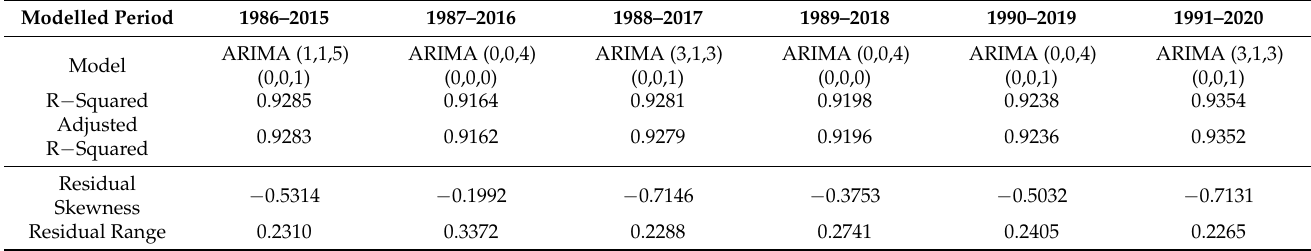
Table A5. FFBI time series forecasting validation models’ summary with residual analyses using descriptive and inferential statistics at α = 0.01.